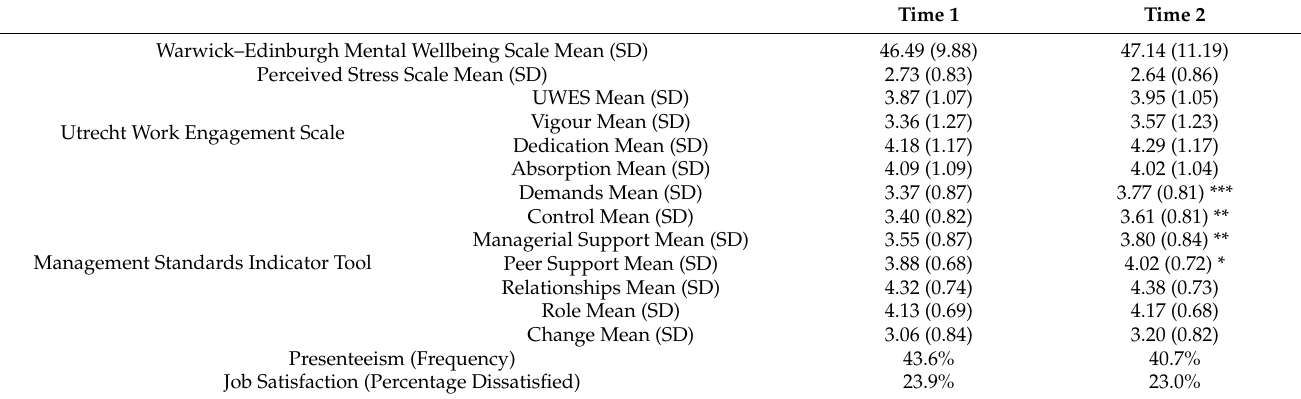
Table 2. Descriptive statistics for all measures used within the project pre- and